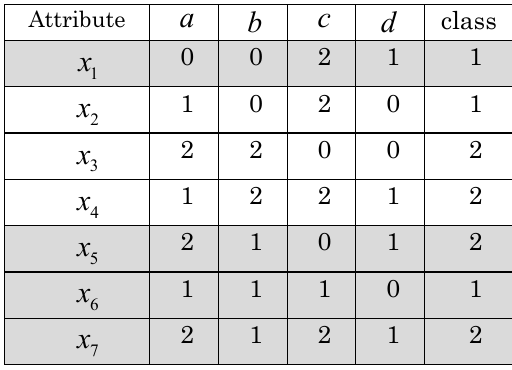
Table 1. Data example of decision table